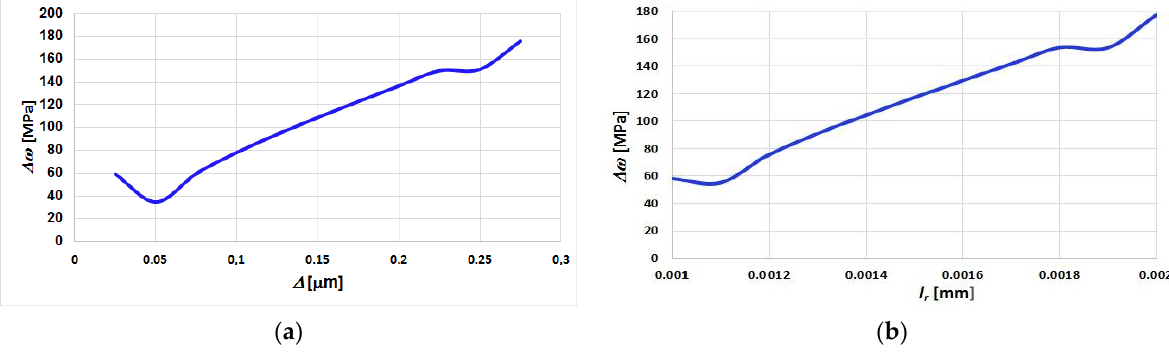
Figure 3. An example of the influence of surface roughness ( a ) and the length of the spray hole ( b ) on pressure losses ∆ ω .